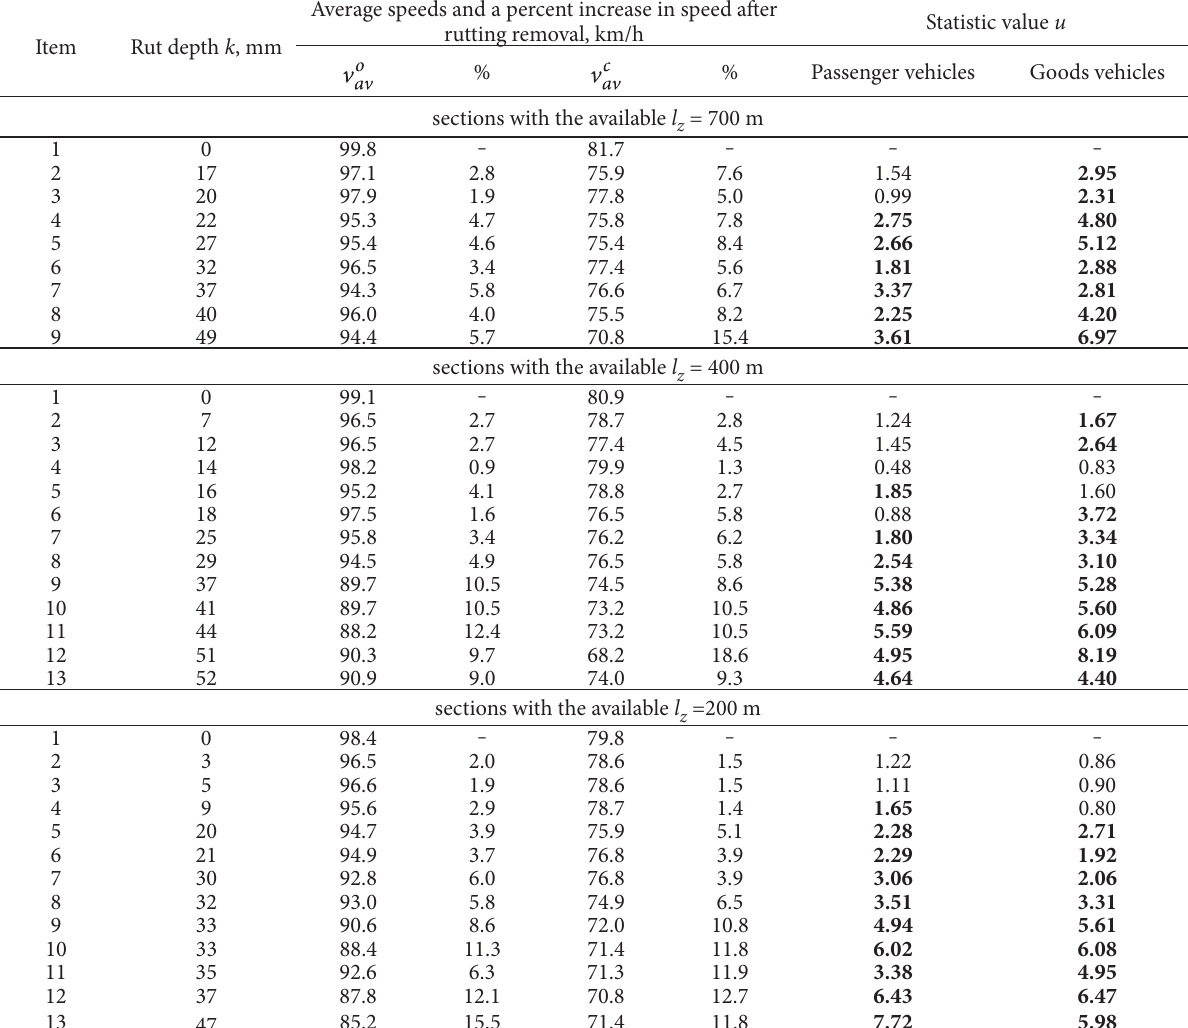
Table 4. Results of the significance test and speed measurements for research sections before rutting removal (Sołowczuk 2005) Average speeds and a percent increase in speed after Statistic value u rutting removal, km/h Item Rut depth k , mm % % Passenger vehicles Goods vehicles sections with the available l z = 700 m